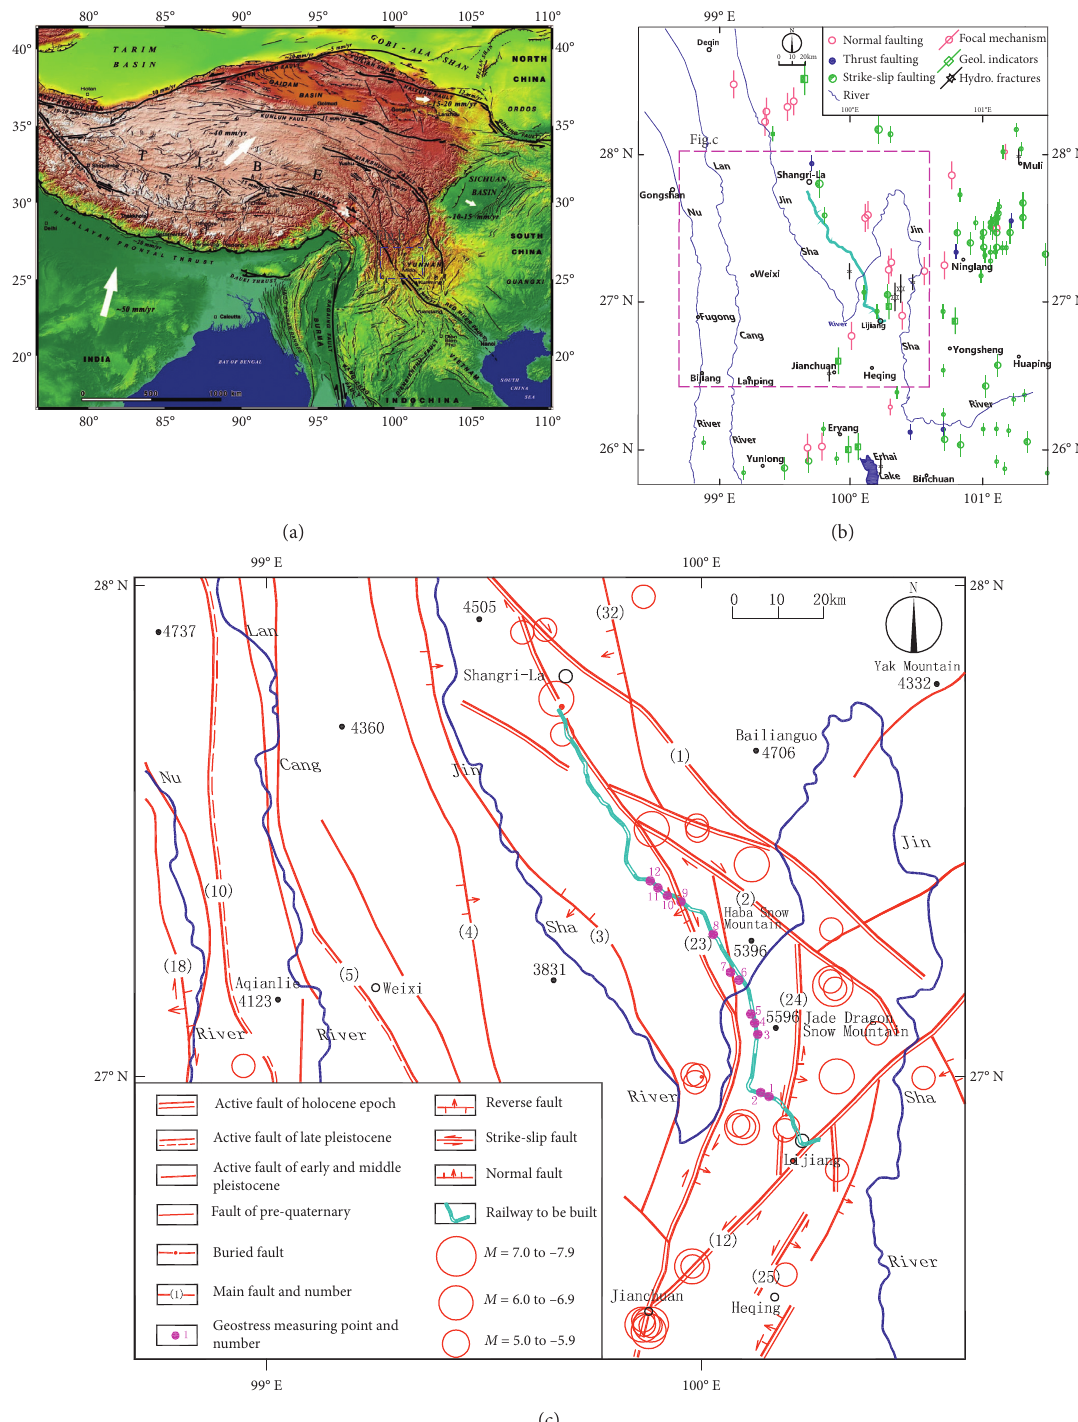
Figure 1: Topography and geologic structure map of the study area. (a) Topography and principal faults in Tibet and adjacent regions [17]. (b) The stress map of the study area and adjacent regions; the stress data are quoted from Heidbach et al. [18]. (c) Geological structure map with historical earthquake epicentres in the region including the Lijiang to Shangri-La railway. 1. Zhongdian-Hailou Fault; 2.